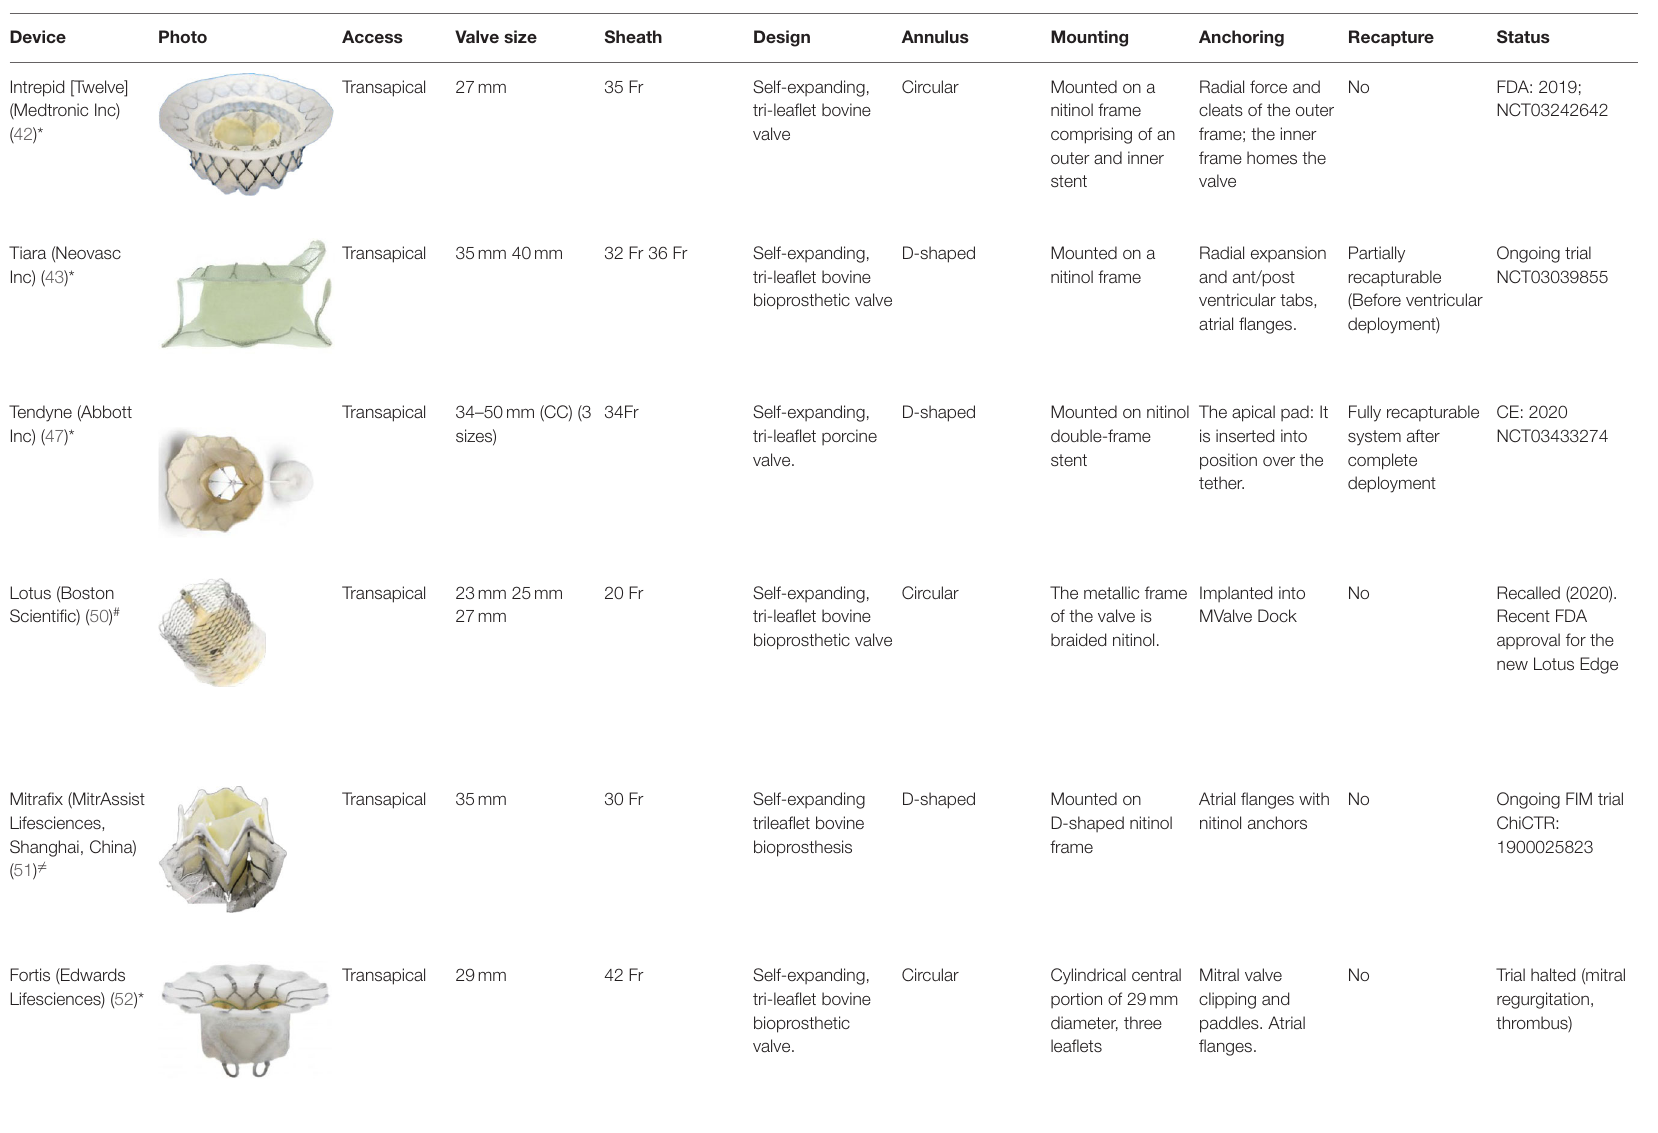
TABLE 2 | Transcatheter mitral replacement devices: Device profile, design, and